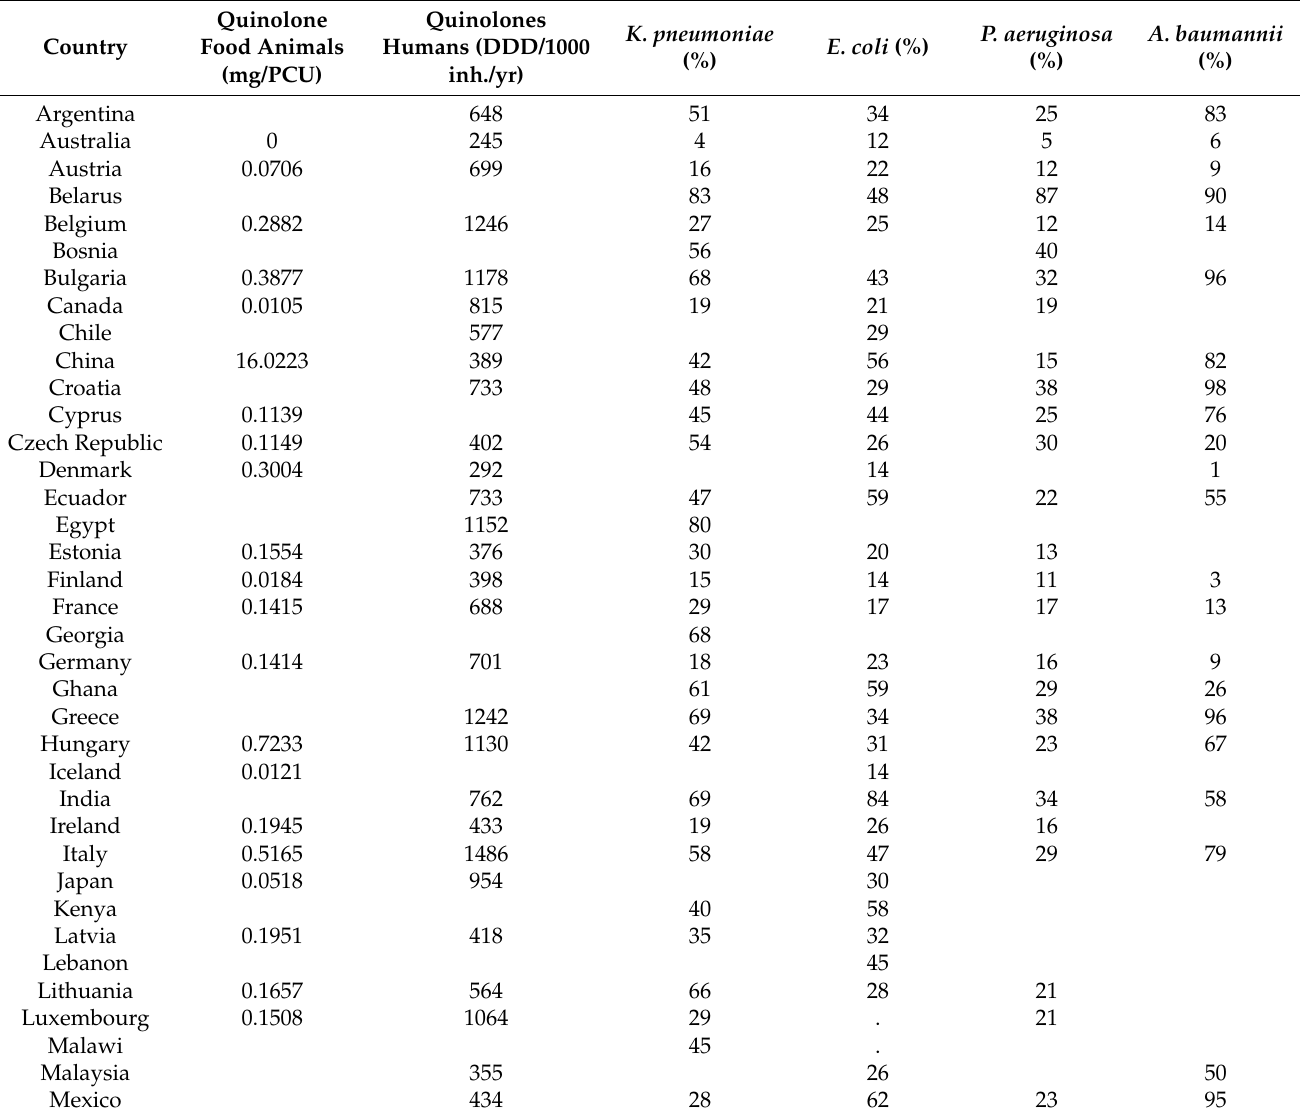
Table 1. Country-level consumption of quinolones for food-producing animals (milligrams of quinolones used for animal food production/PCU), fluoroquinolone consumption in humans (defined daily doses[DDD]/1000 inhabitants per year) and prevalence of resistance to fluoroquinolones (%) for 4 bacterial